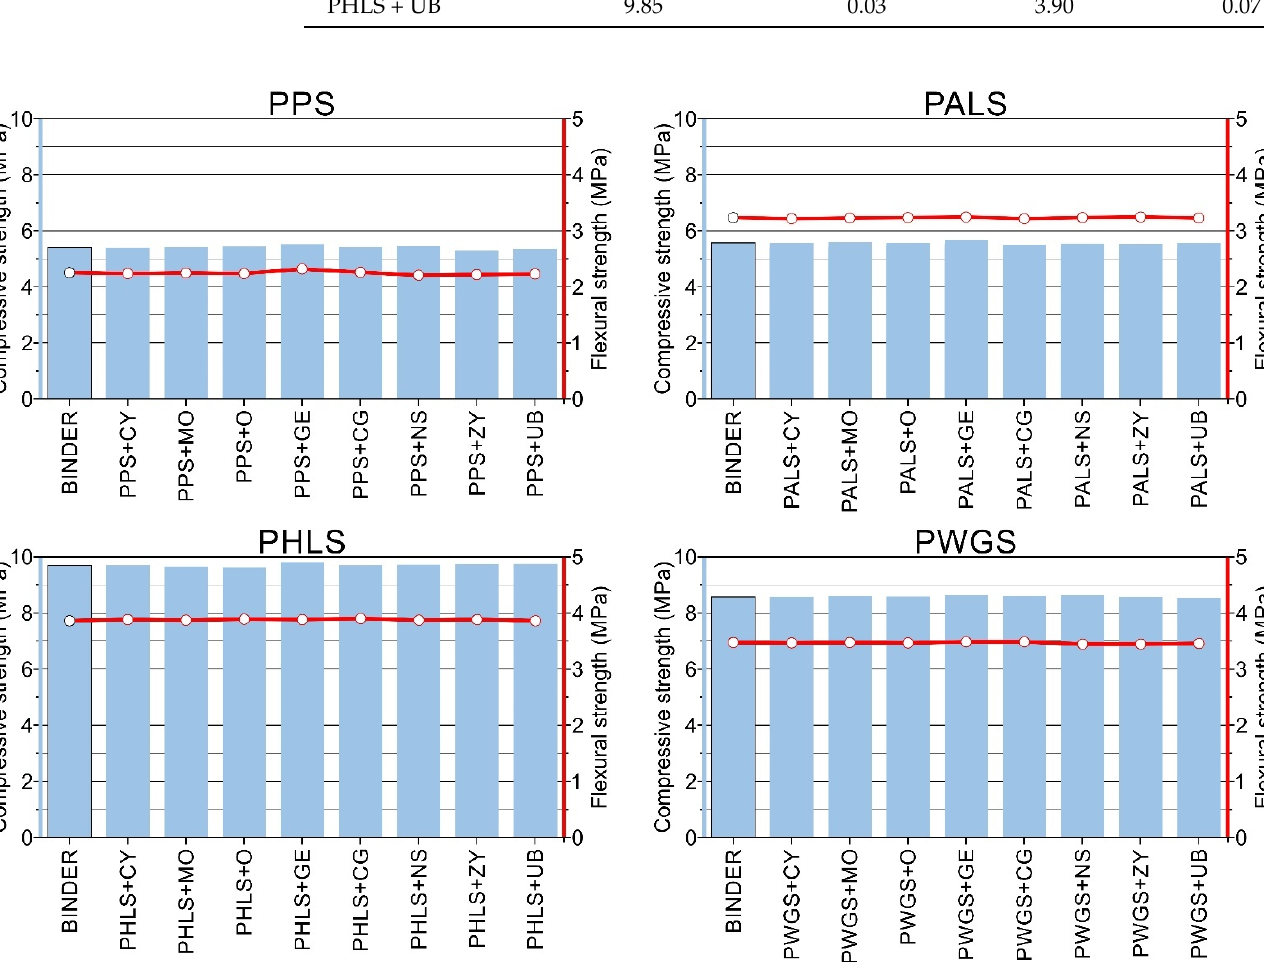
Figure 5. Mechanical strength values (MPa) of binders at 120 days and their corresponding pigment- colored pastes (PPS, PALS, PHLS and PWGS). Blue bar plot corresponds to compressive strength. Line plot with red circles corresponds to flexural strength.